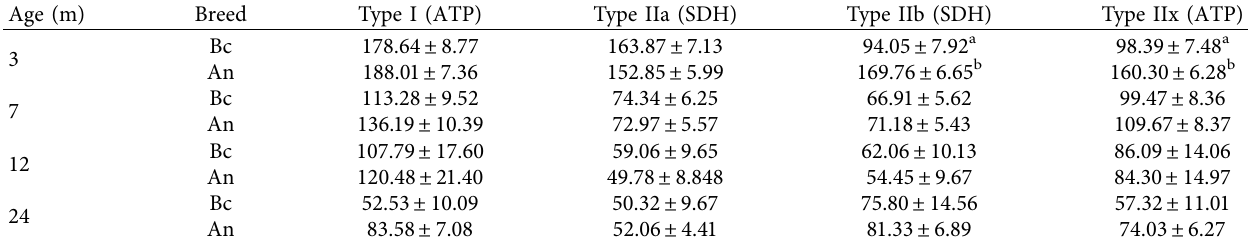
Table 3: Comparison of different types of muscle fiber density between the same month of Xinjiang brown cattle and Angus cattle of longissimus dorsi muscle. Bc means Xinjiang Brown cattle and An means Angus cattle. Type I is dark, type IIa and type IIb are light, and type